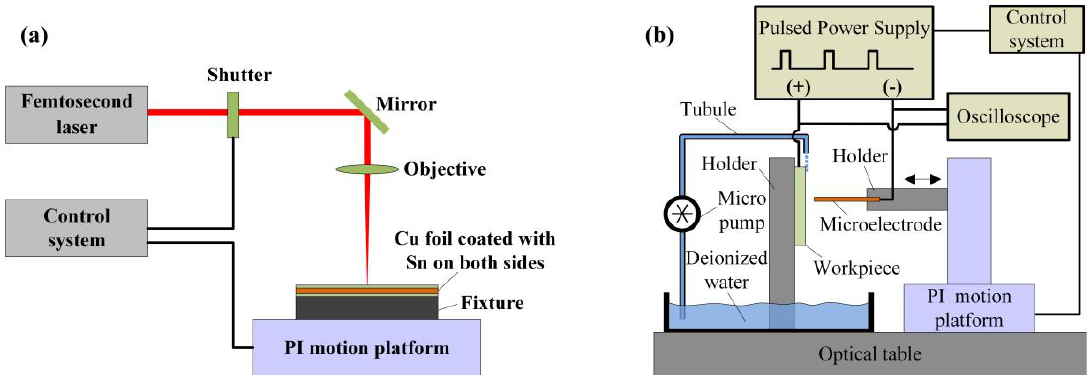
Figure 1. Schematic diagram of experimental setup: ( a ) Femtosecond laser cutting system; ( b ) Micro- electrical discharge machining (micro-EDM) system.